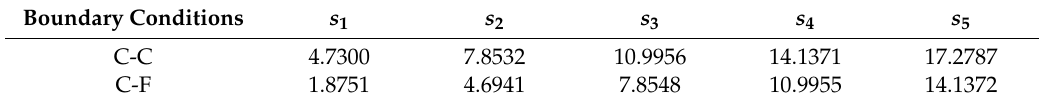
Table 1. The first five modes for clamped-clamped and clamped-free boundary